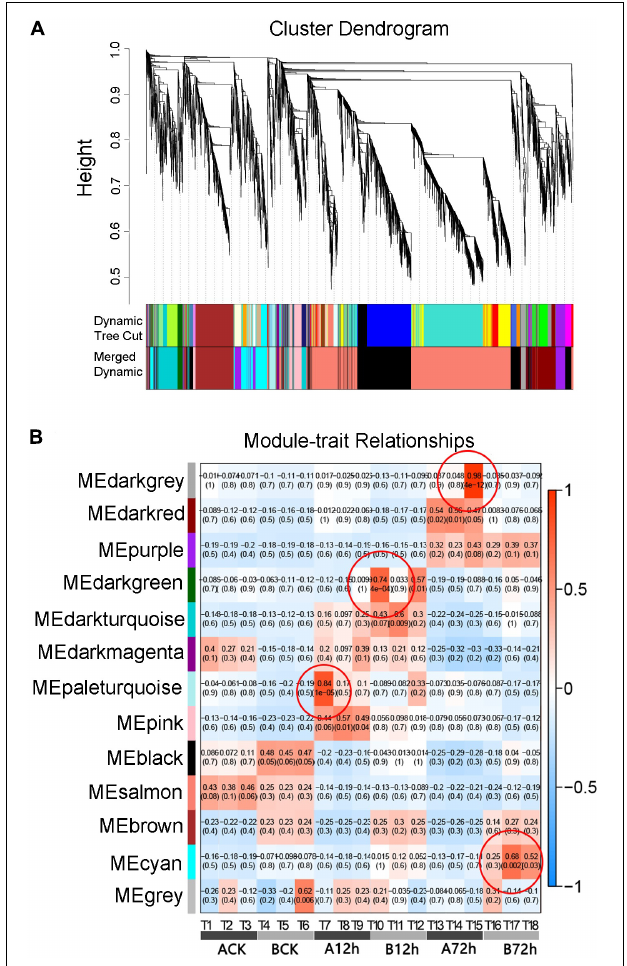
FIGURE 4 | Analysis of WGCNA and module-trait relationships. (A) The gene clustering tree and the module-clustering diagram. (B) Correlation coefficients between modules and